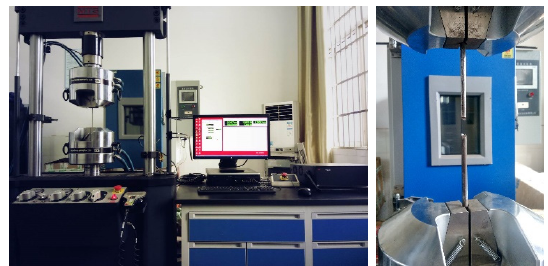
Figure 3. Test setup.